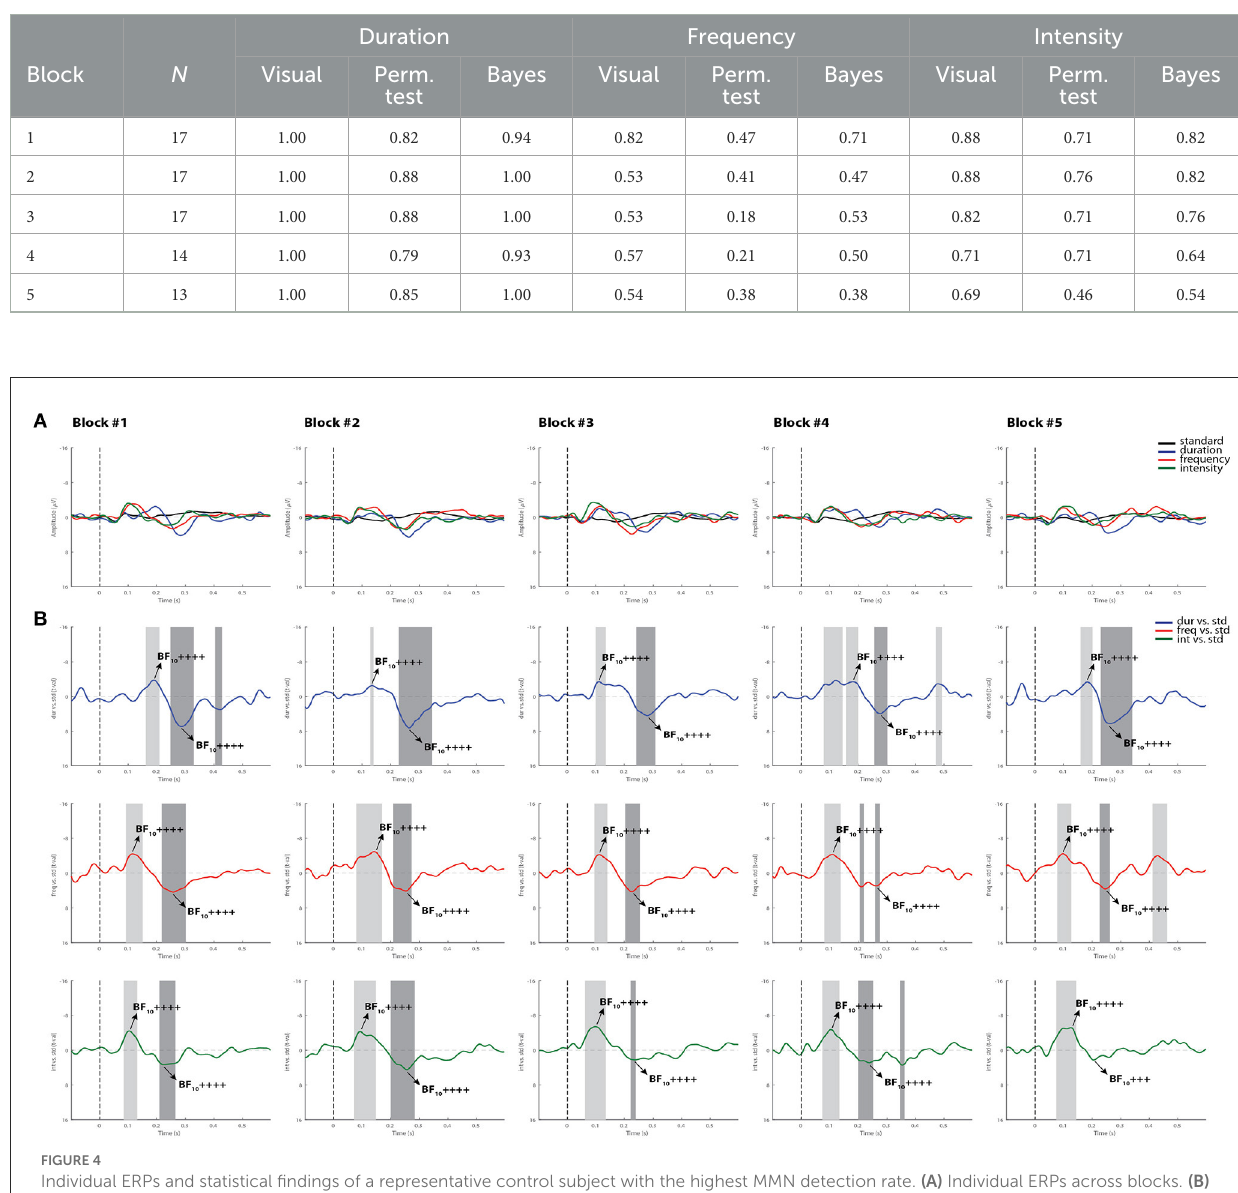
TABLE 3 Proportion of healthy controls showing evidence of P3a in each block.